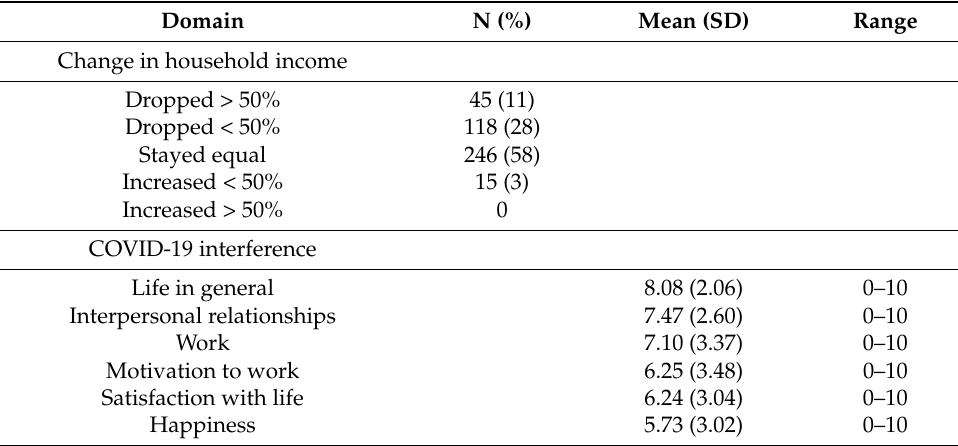
Table 5. Descriptor statistics for socio-economic impact variables (N =